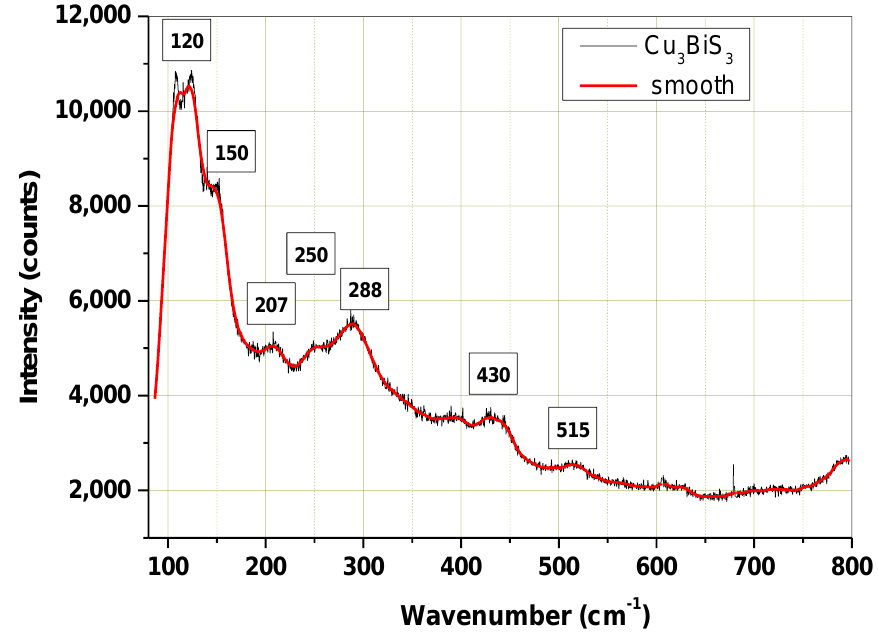
Figure 2. Micro-Raman spectrum of mechanochemically synthesized Cu 3 BiS 3 after 5 min of